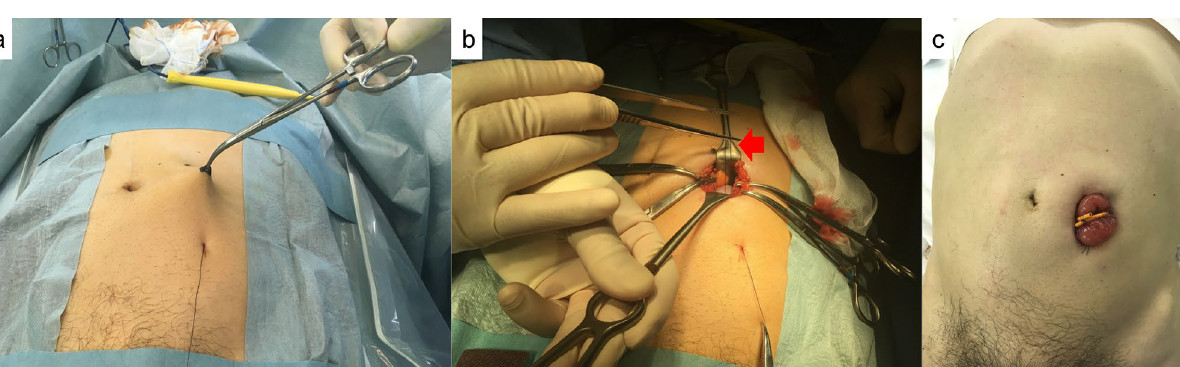
Figure 3. Puncture of the sigmoid colon and placement of the thread with a metal bar attached (T-bar). ( a ) An exploratory puncture is made using a 23-gauge needle. ( b , c ) The 2-shot anchor device is inserted into the interior space of the sigmoid colon, and the thread with T-bar is detached.